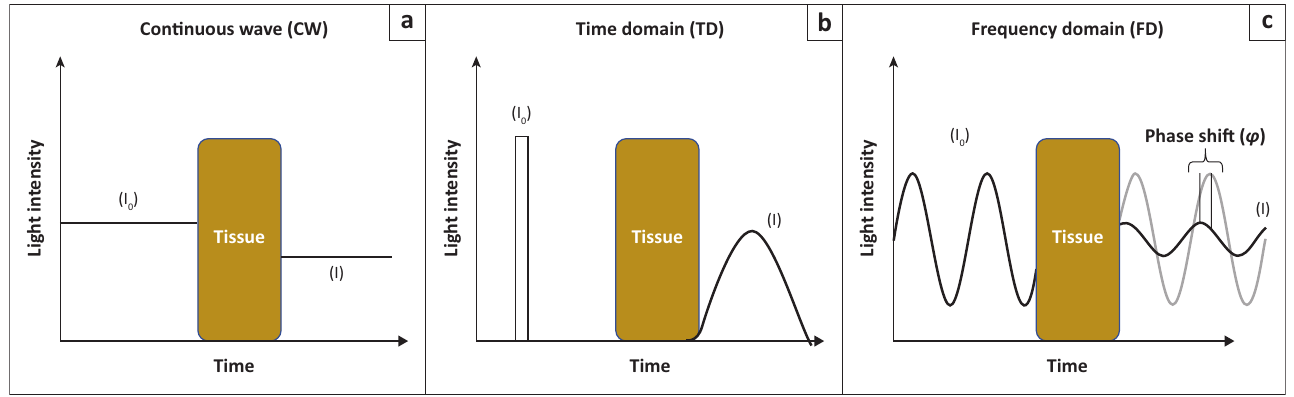
FIGURE 2: Representation of light propagation for the three types of functional near-infrared spectroscopy technique: the continuous wave (CW), time domain (TD) and frequency domain (FD). I = intensity of the emitted light, I = intensity of transmitted (light after cross the tissue) and ϕ = phase shift. The features of the light 0 such as intensity and phase change when it crosses the head (represented on the diagram by the tissue). Note that only in the CW system the intensity of the emitted light is constant.